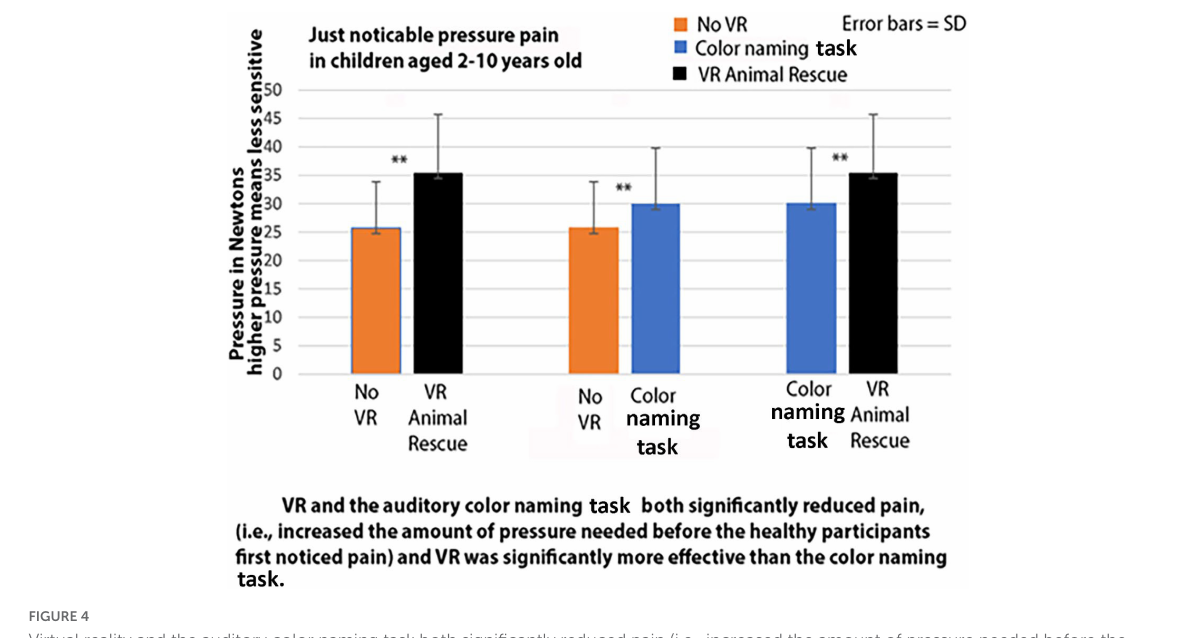
FIGURE4 Virtual reality and the auditory color naming task both significantly reduced pain (i.e., increased the amount of pressure needed before the healthy participants first noticed pain) and VR was significantly more effective than the color naming